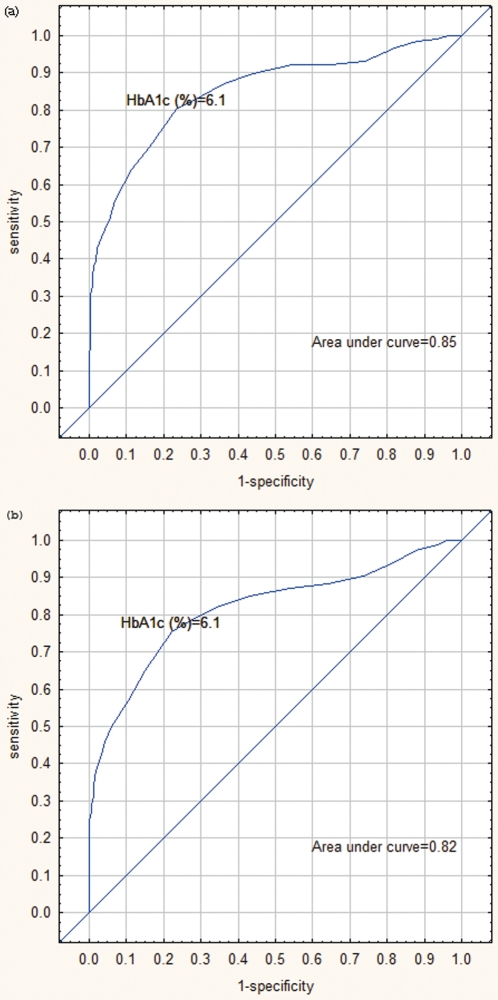
ROC curves depicting an HbA1c cut-off value of 6.1% as optimal for the diagnosis of DM according to fasting blood glucose and the OGTT.Figure 1a area under curve = 0.85, sensitivity = 80%, and specificity = 77%. Figure 1b area under curve = 0.82, sensitivity = 75%, and specificity = 78%.